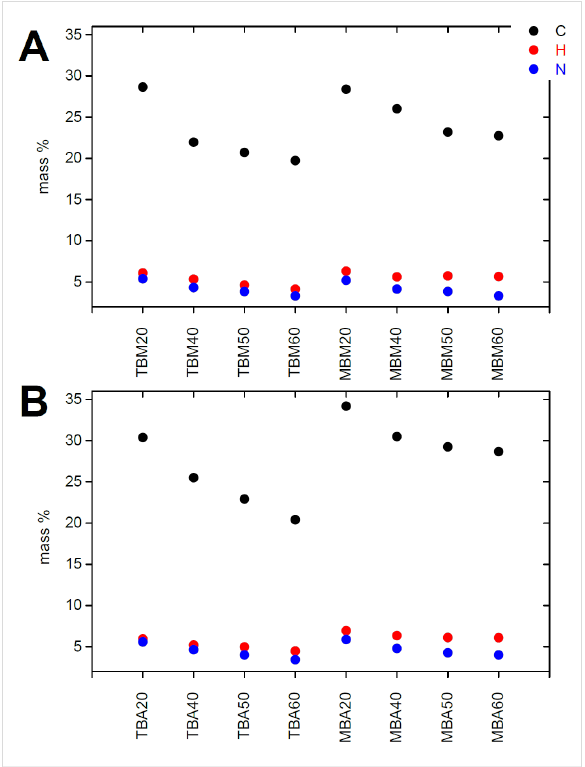
Figure 3: Carbon, hydrogen, and nitrogen contents of silica monoliths made from methanol (A) and acetone